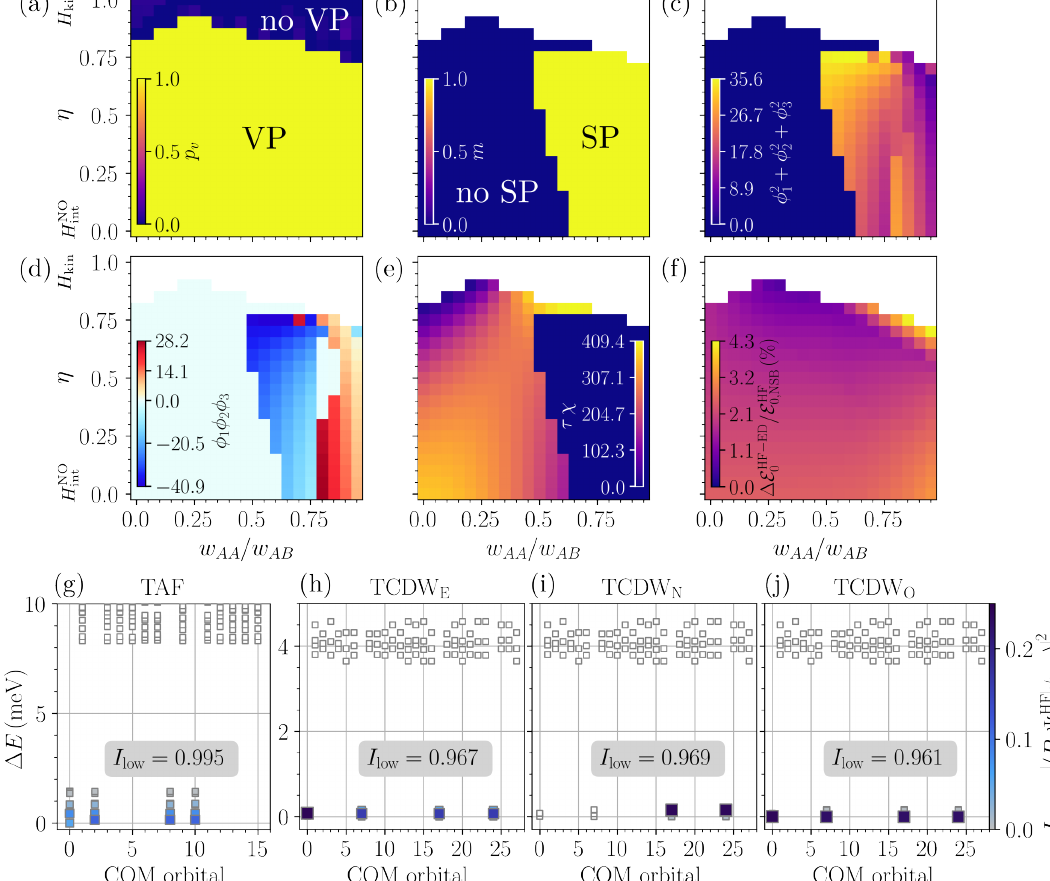
Figure 6: (a)-(b) The relative valley polarization p reproduce the respective quantities from Fig. 3 (a)–(b) to a high degree of